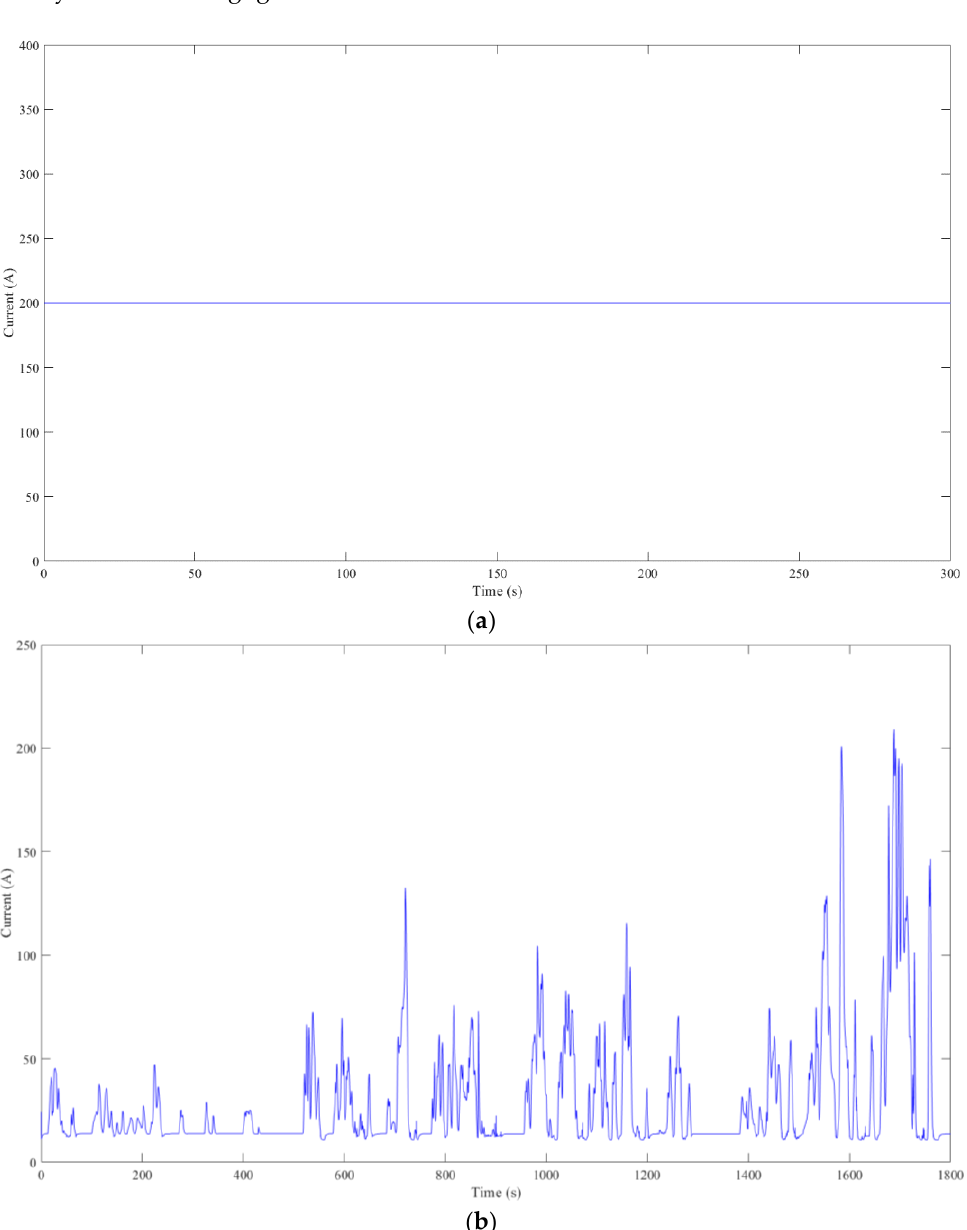
Figure 15. Two working conditions: ( a ) steady working conditions and ( b ) variable working condi- tions.